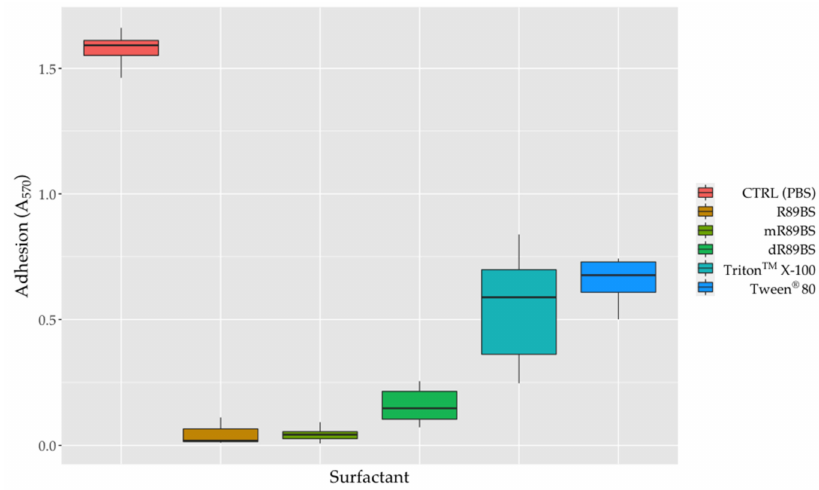
Figure 6. Bacterial adhesion on silicone discs. The efficacy of the surfactants surface treatment on SEDs was evaluated as reduction of S. aureus ® 6538 TM adherent cells after 6h of incubation at 37 ◦ C, compared to controls SEDs.